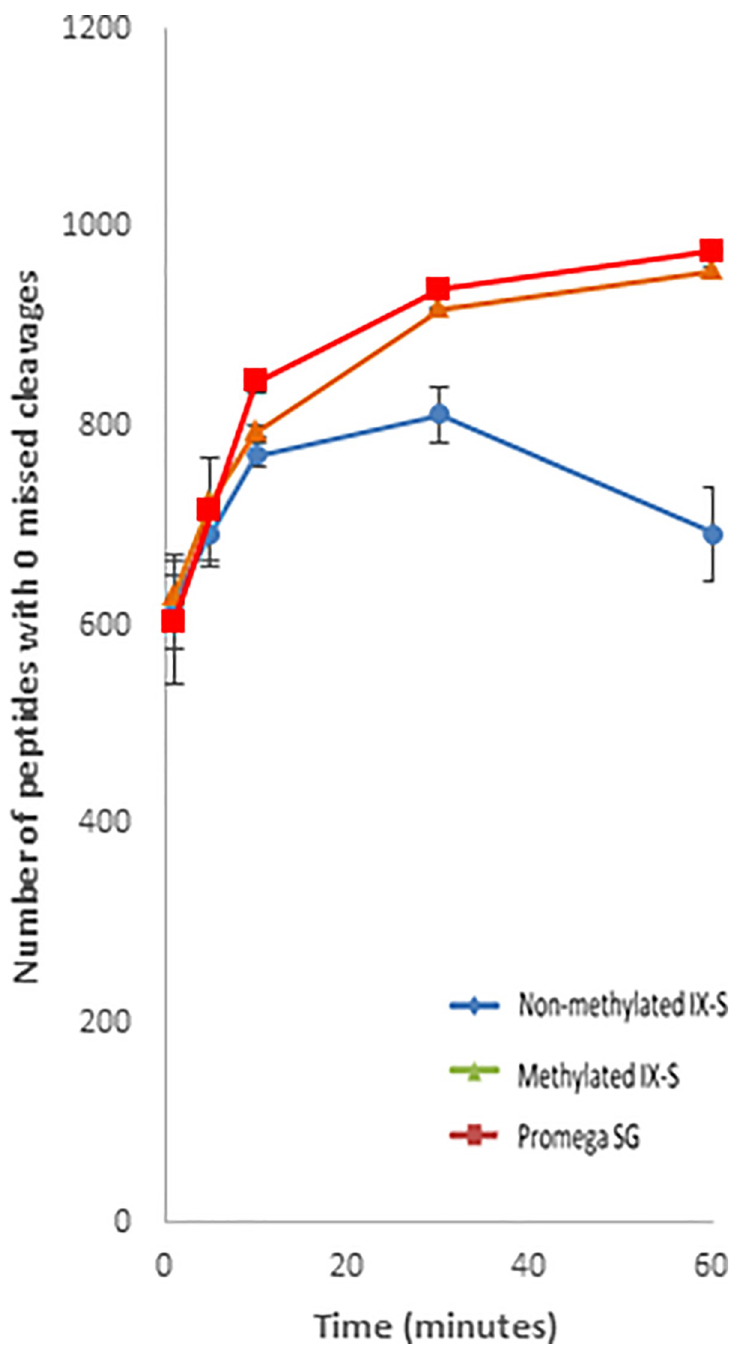
Fig 5. Identified peptides of HeLa lysate. Number of identified peptides with 0 missed cleavages identified after digestion of a HeLa lysate at 58˚C using either crude (blue diamonds), enhanced Sigma IX-S (red squares) or PSG (green triangles)